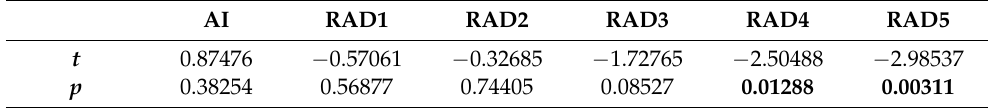
Table A5. Two-tailed independent t -test results between radiologists with and without AI help. Bolded values represent statistical significance at the p < 0.05 level ( df 1 = 129, df 2 =